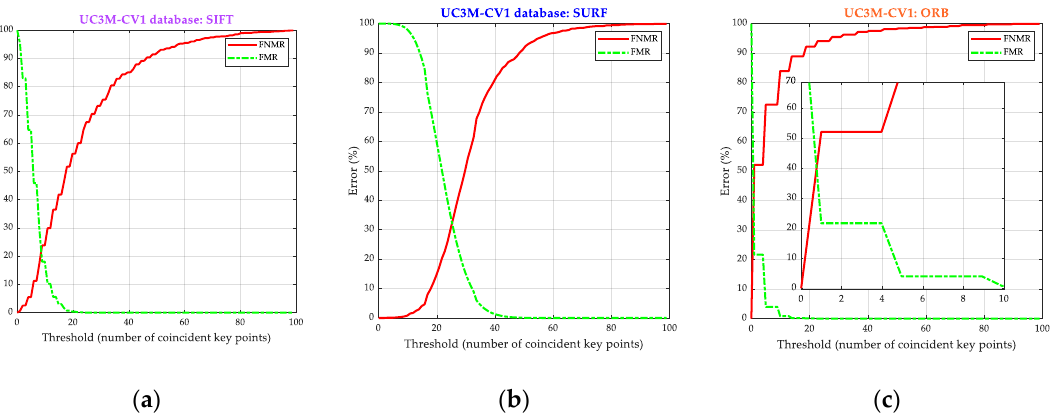
Figure 12. Results: biometric system performance. It is represented the percentage of error, False Match Rate (FMR) (line-dot green curve), and False Non-Match Rate (FNMR) (continuous red curve) versus the threshold of the number of coincident key points. ( a ) SIFT ® . ( b ) SURF ® . ( c ) ORB.